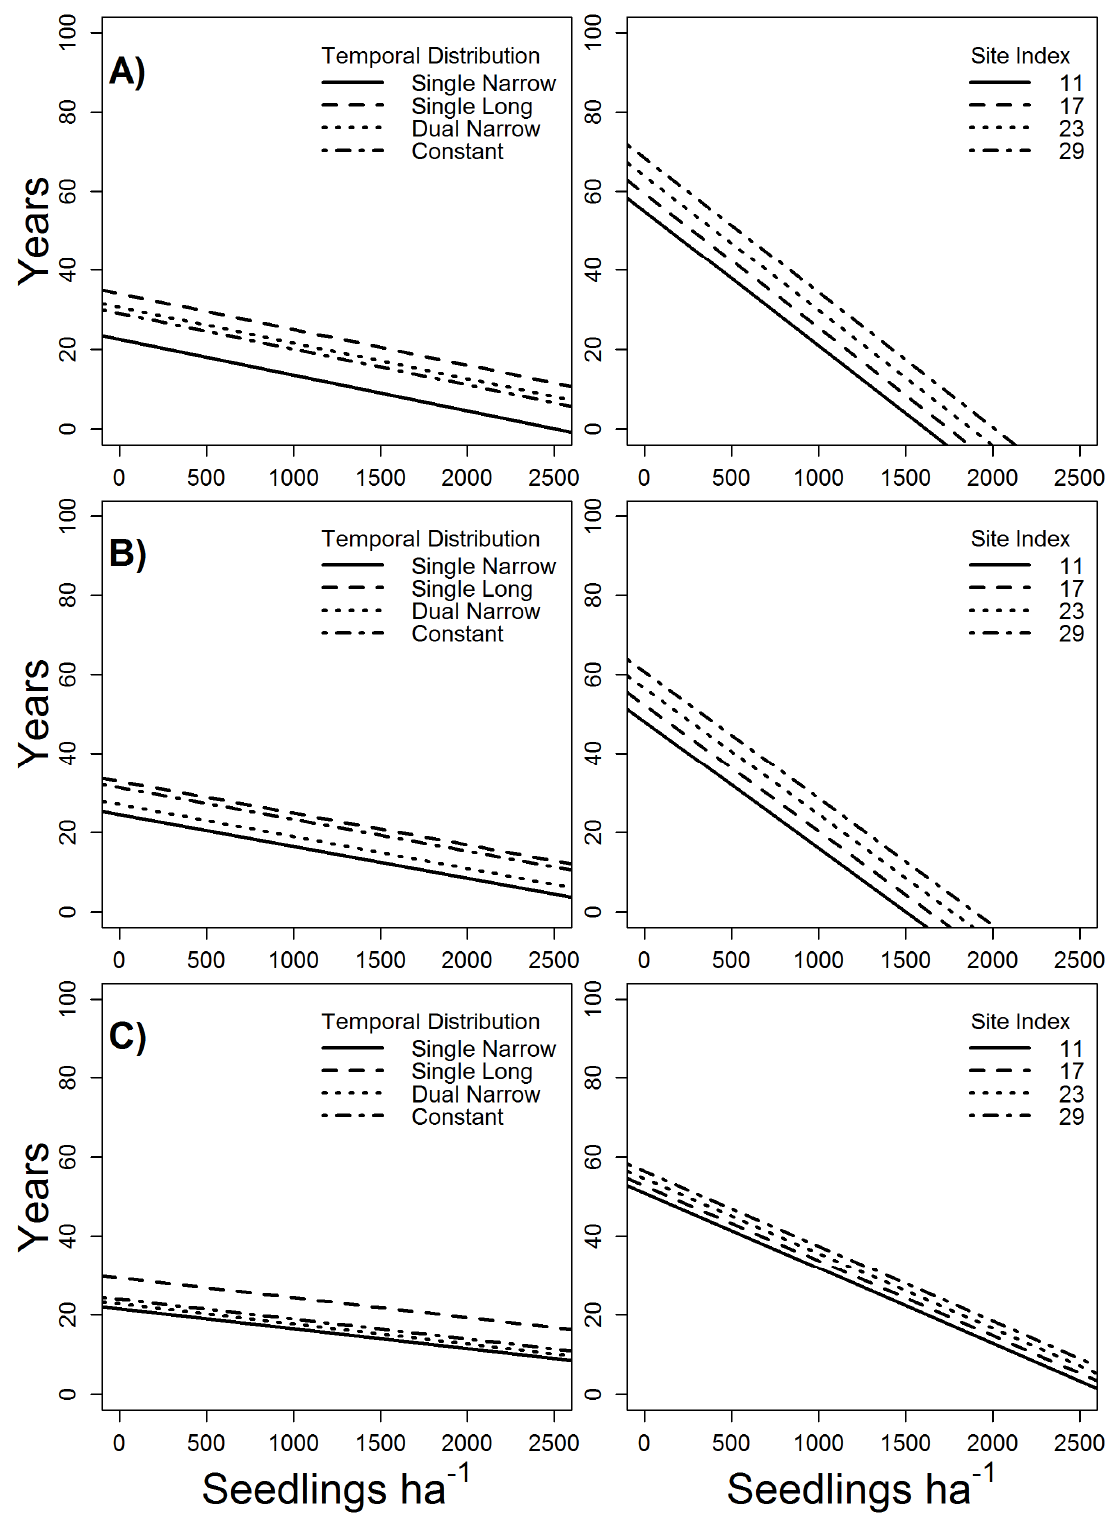
Figure 5. Impact of setting the FVS CRNMULT to ( A ) default; ( B ) 0.5, and ( C ) 0.0 on the time to return to within 10% of pre-treatment wind speeds for Torching ( left ) and Crowning ( right ) Indices. Overall, increasing seedling density reduced treatment longevity as a function of both Torching and Crowning Indices, supporting hypothesis H1. Additionally, increasing the temporal distribution of seedlings entering the simulation reduced treatment longevity in terms of Torching Index, partially